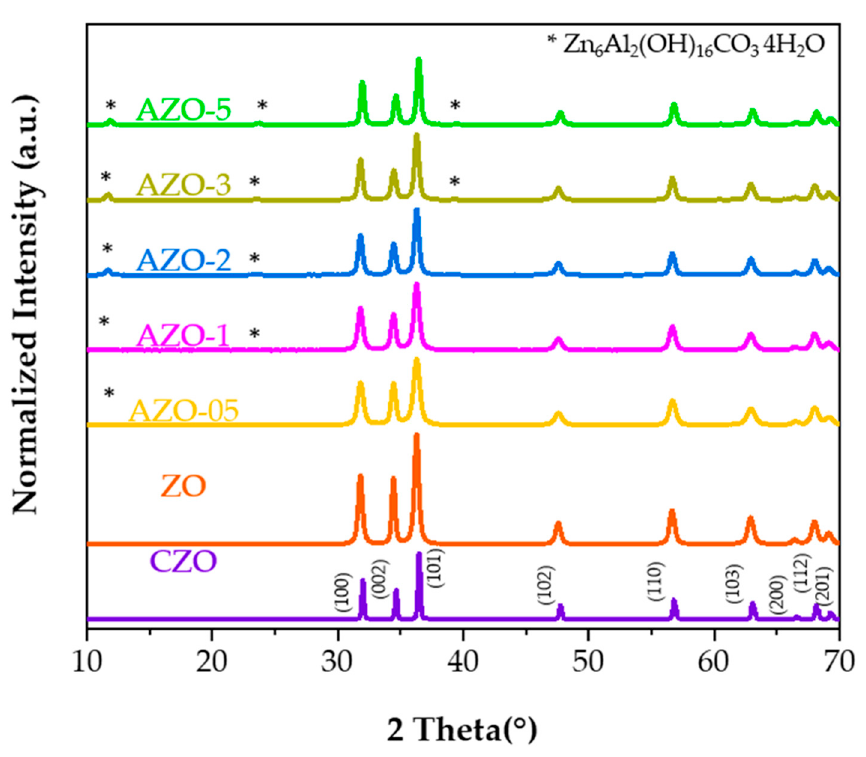
Figure 1. X-ray diffraction patterns of undoped ZnO and Al-doped ZnO powders as-synthesized with different aluminum content. CZO is used as reference material. Symbol: *—corresponds to the secondary phase: Zn 6 Al 2 (OH) 16 CO 3 4H 2 O.